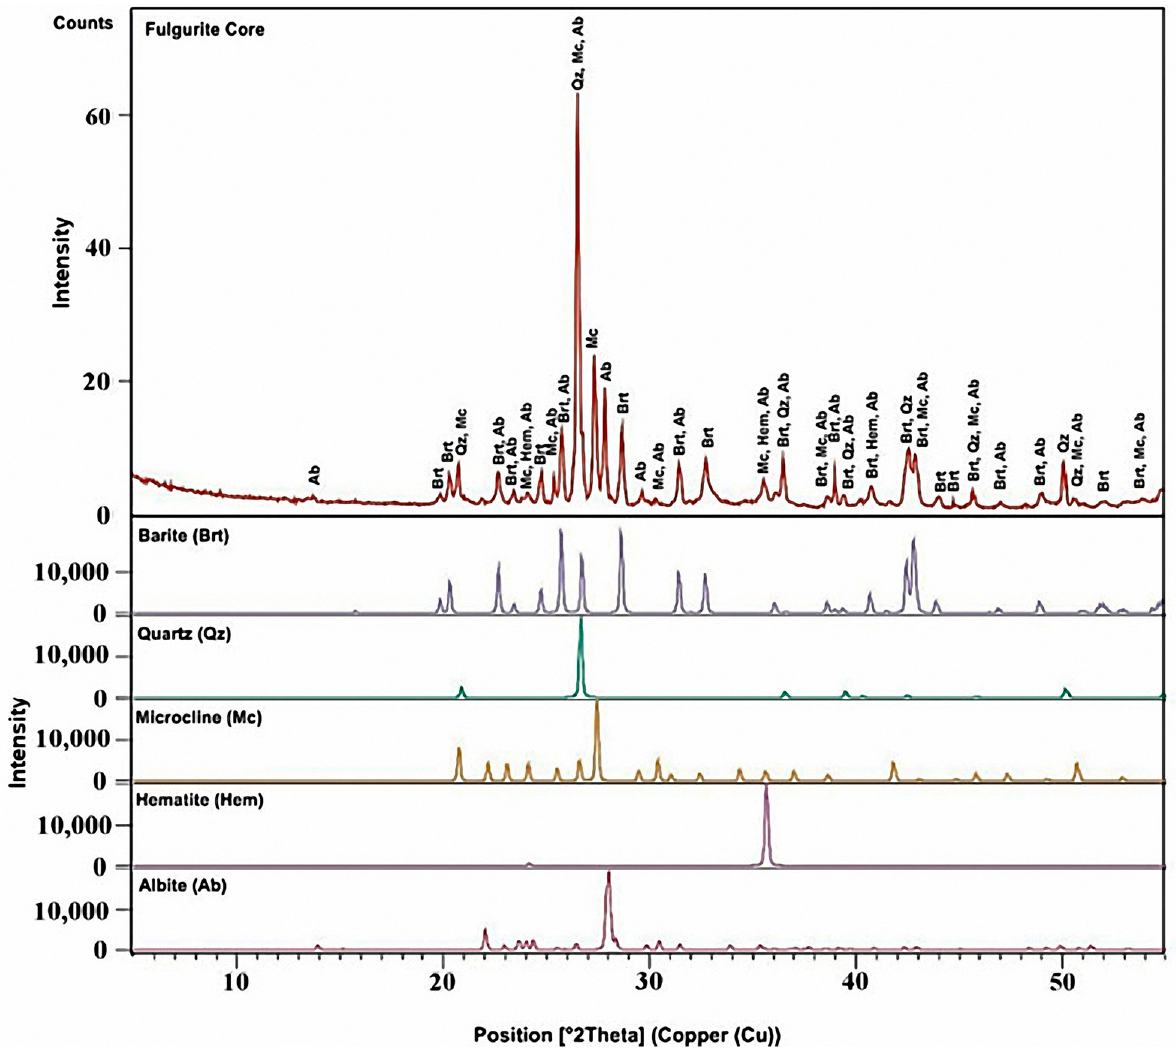
Figure 11. X-ray powder diffraction pattern of the fulgurite core sample. Brt: barite; Qz: quartz; Mc: microcline; Hm: hematite; Ab: albite. The observed diffractogram of the sample corresponds to the red line shown in the top panel of the figure, while the separate contributions of the different min- erals present in the sample are shown in different colors in the remaining panels. COD IDs of the reference diffractograms (ICSD Database): quartz, 01-083-0539; barite, 01-089-3749; microcline, 00- 019-0926; hematite, 01-072-0469; albite, 00-001-0739.